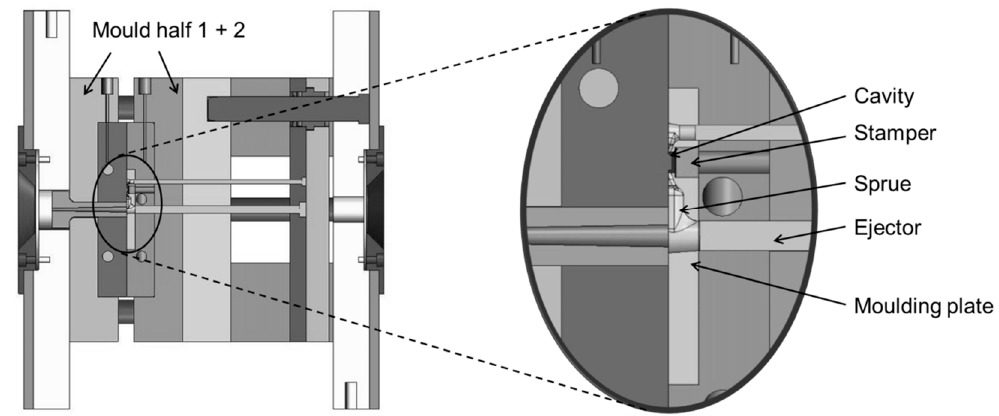
Figure 17. Design of the injection mold for encoder discs.